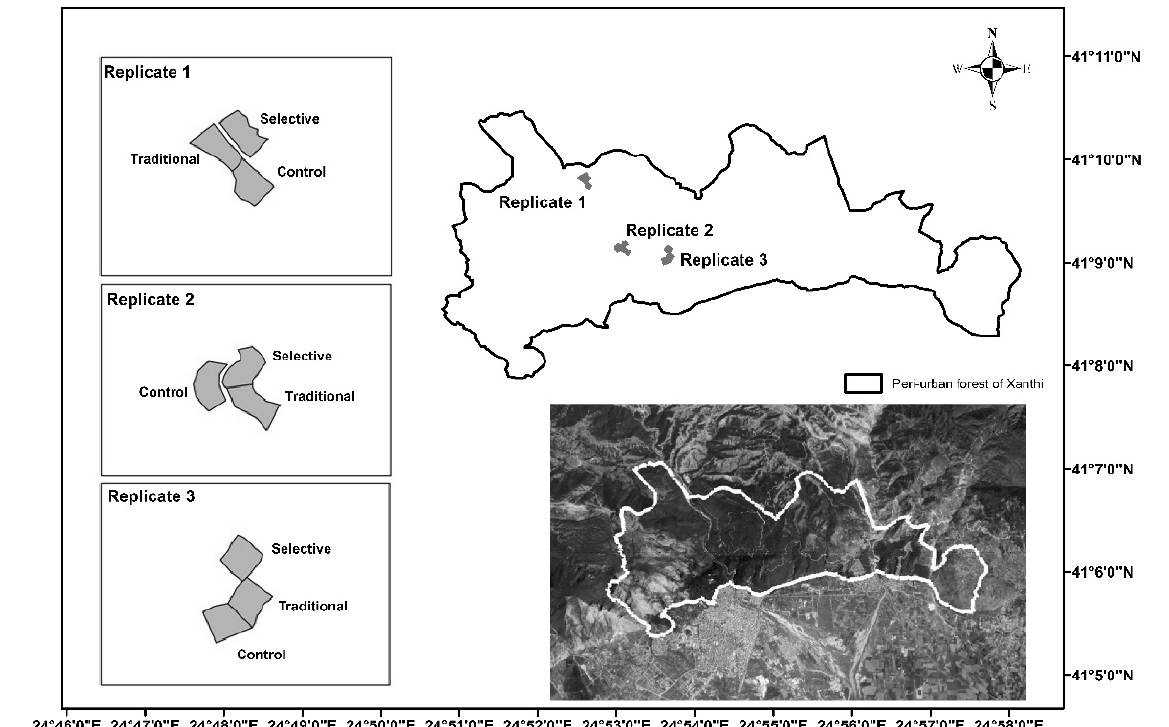
Figure 1. Shape and location of the study site. Peri-urban forest is marked with thick white solid line (Xanthi Forest Directorate).